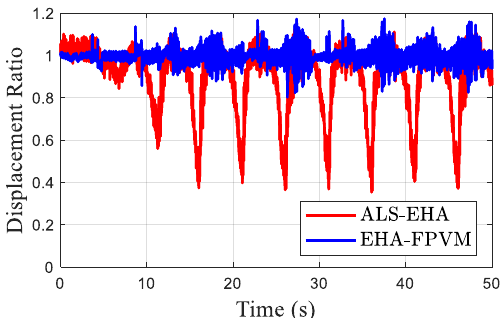
Figure 18. Displacement ratio change curve.